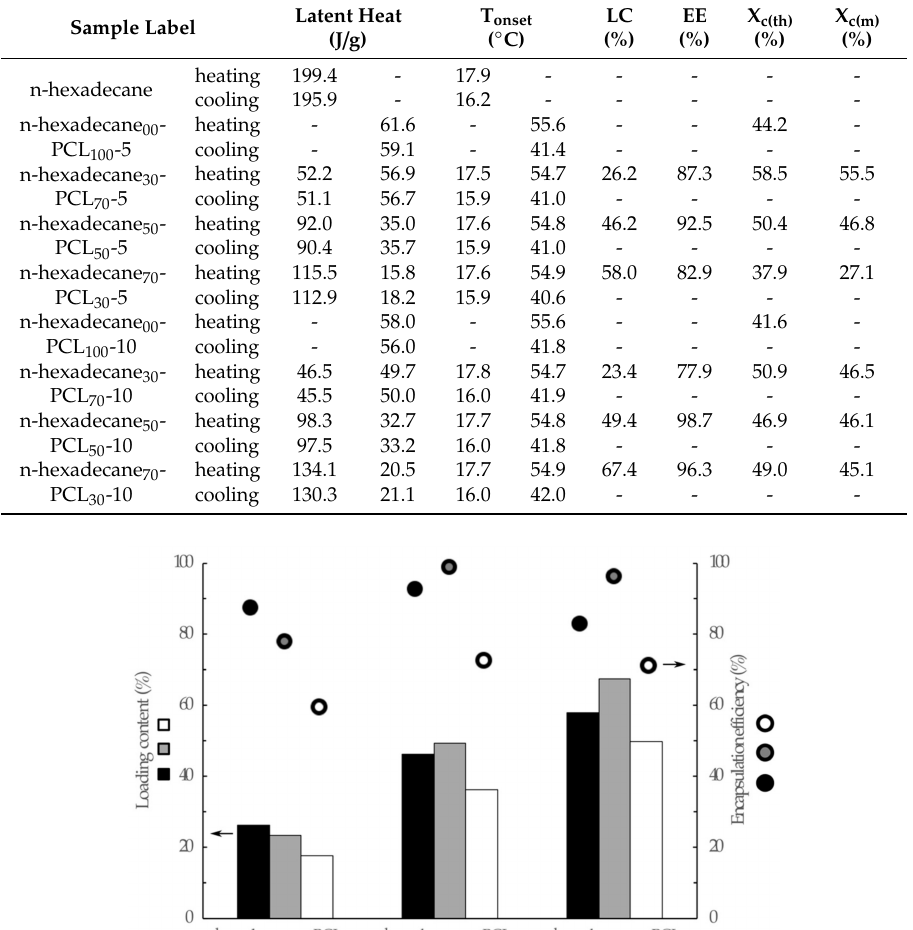
Figure 3. DSC thermograms of raw n-hexadecane, neat PCL microparticles and a series of n-hexadecane / PCL microcapsules obtained from PCL concentrations at 5 ( a ) and 10 ( b ) w / v % with di ff erent loading ratios between n-hexadecane and PCL. Table 3. Thermal properties of n-hexadecane, neat PCL microparticles and a series of n-hexadecane / PCL microcapsules obtained from di ff erent PCL concentrations at three loading ratios between n-hexadecane and PCL.